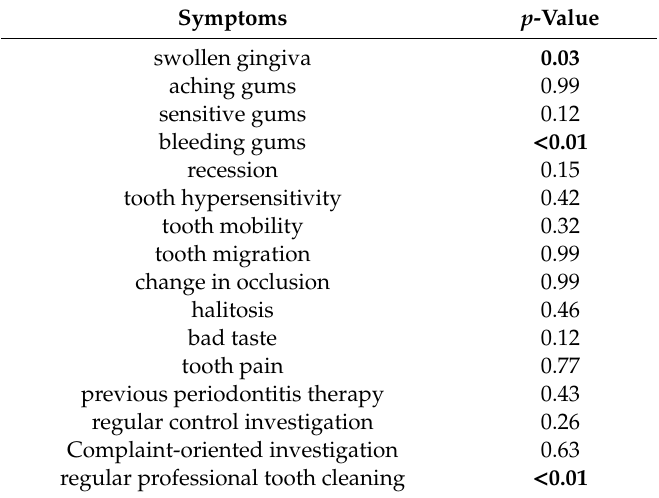
Table 5. Association between periodontitis questionnaire and periodontal treatment need within the total cohort; significance level: p <